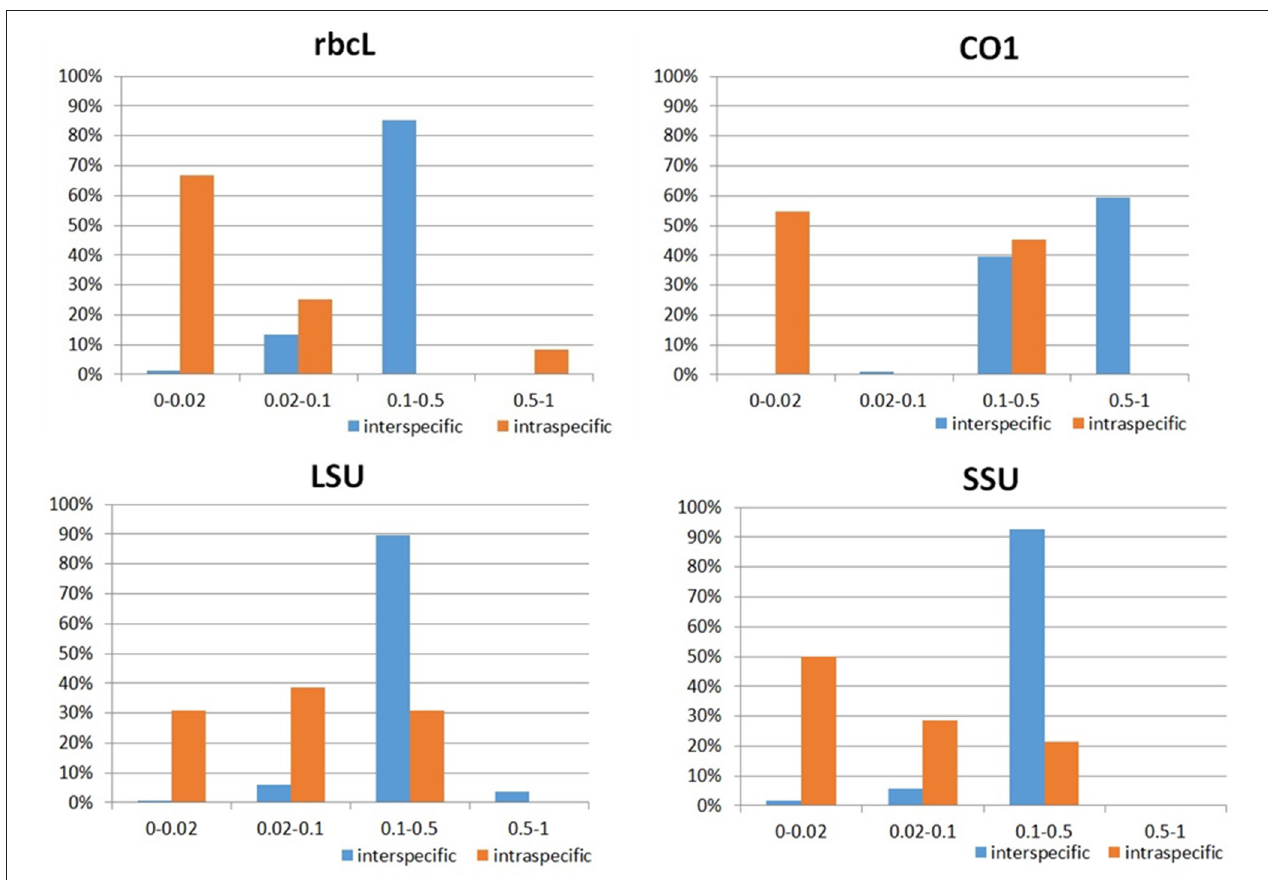
FIGURE 2 | Proportion of intraspecific and interspecific distances for rbcL , COI, LSU, and SSU, respectively.